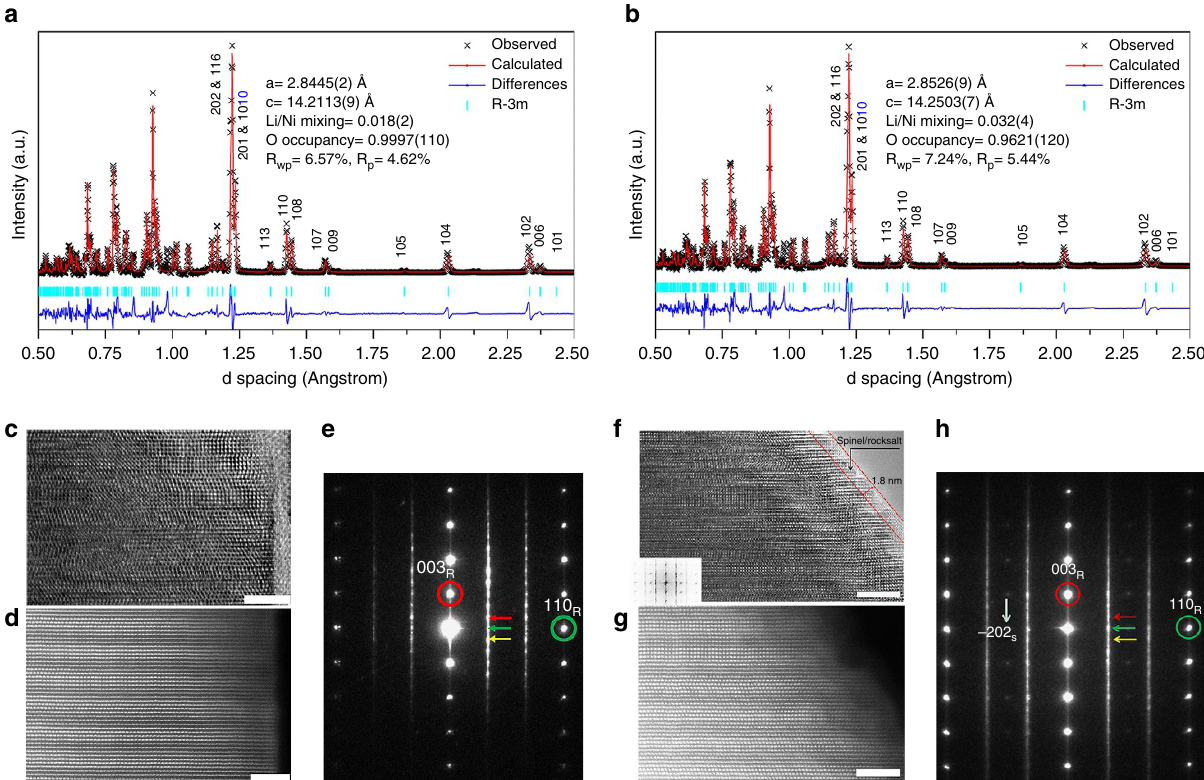
Figure 2 | Structural characterizations of the pristine and GSIR LR-NCM. ( a , b ) TOF ND patterns for the pristine and GSIR LR-NCM. On the basis of these results, the oxygen vacancy for the GSIR LR-NCM is around three per cent higher than that of the pristine LR-NCM sample; ( c ) high-resolution transmission electron microscopy (HRTEM) image and, ( d ) high-angle annular dark-field—STEM (HAADF-STEM) image for the pristine LR-NCM; ( e ) electron- diffraction (ED) pattern for the pristine LR-NCM. The elongation of these spots are along [001] R * as well as [001] M * direction. The spots indicated with red, green and yellow arrows represent (110), (020) and ( (cid:2) 110) of the monoclinic Li 2 MnO 3 (donated as M) variants [1–10] M , [100] M and [110] M , respectively. The spot marked by a red circle is shared by (003) R of the rhombohedral (donated as R), as well as the structure (001) M of all monoclinic variants. The spot marked by a green circle is shared by (110) R of the rhombohedral, as well as the structure (33-1) M , (060) M and (–331) M of the monoclinic. ( f ) HRTEM image with fast Fourier transform (FFT) about the surface and ( g ). HAADF-STEM image for the GSIR LR-NCM; ( h ) ED for the GSIR LR-NCM. The weak spot indicated by the white arrow can only be indexed as the structure ( (cid:2) 202) S of the spinel (donated as S). Scale bars,